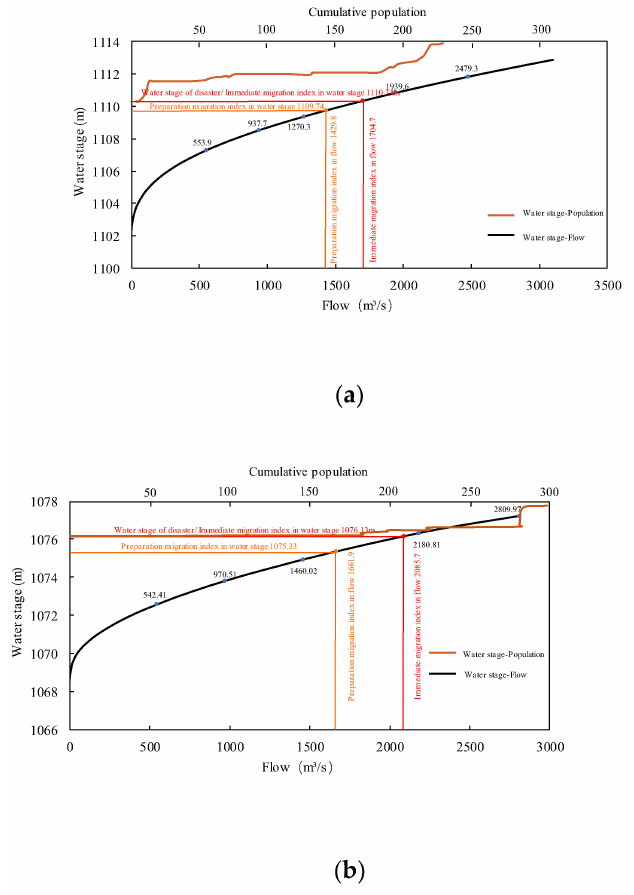
Figure 12. Curve of water stage-flow and population: Anding ( a ), Qiangjiawan ( b